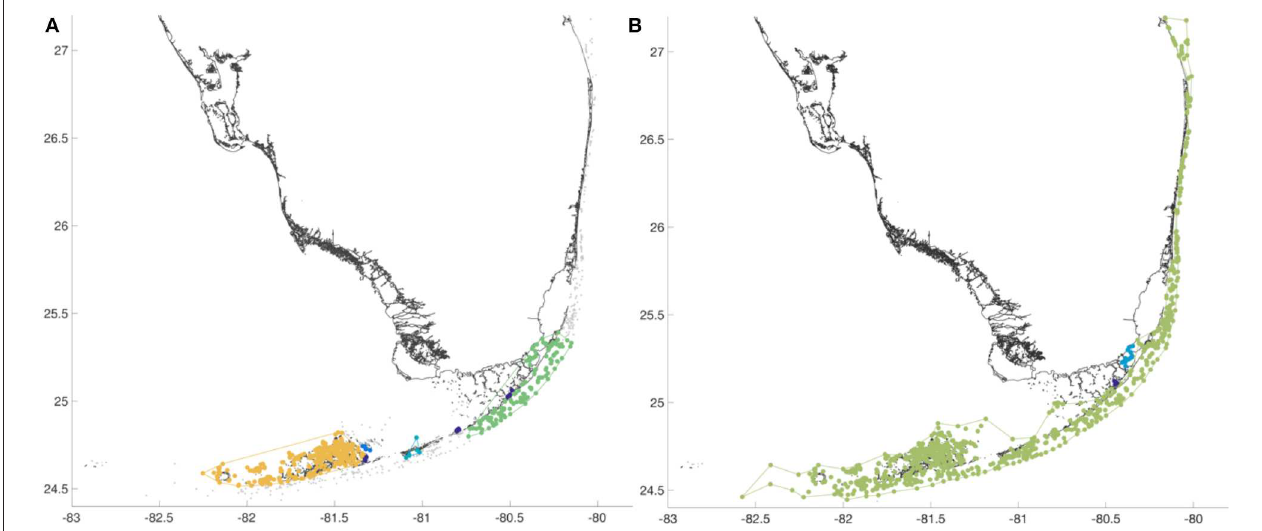
FIGURE 8 | (A) When taking only demographically significant connections into account, the SCC clustering method keeps two main groups of reefs in the Lower and Upper Keys. (B) The community partitioning obtained with the MO method for a resolution parameter ζ = 2 × 10 − 5 shows one major community that encompasses almost all the FRT. The existence of such a large community shows that the FC acts as a conveyor belts that connects almost all the reefs in Keys to the reefs along the outer shelf.